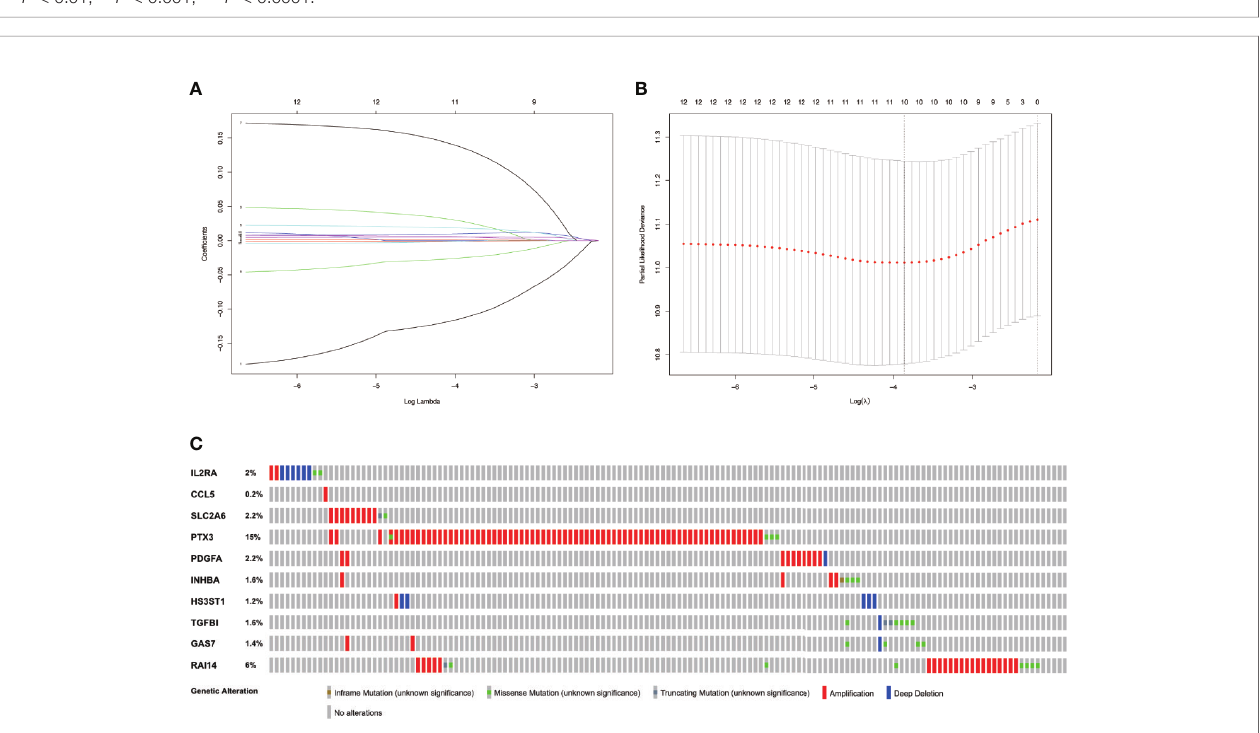
FIGURE 4 | Establishment of prognostic gene signature by LASSO regression analysis. (A) LASSO coef fi cient pro fi les of the 12 prognostic MGMs in the training dataset. (B) A coef fi cient pro fi le plot was generated against the log (lambda) sequence. (C) Genetic alteration of the ten genes in the TCGA-HNSCC cohort (TCGA, Firehose